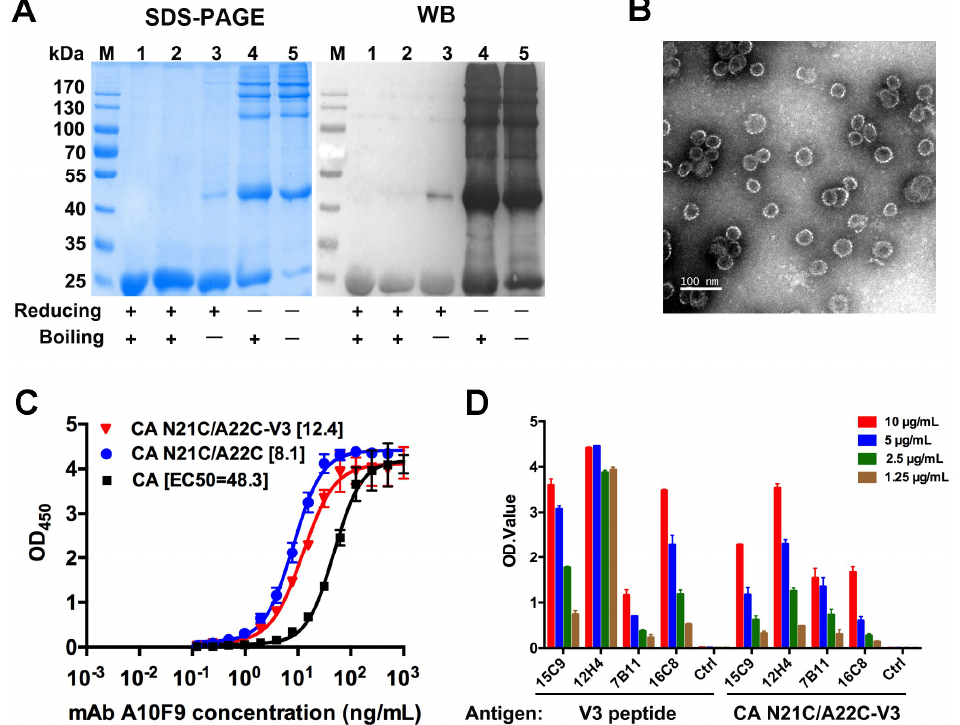
Figure 4. Characterization of CA N21C/A22C-V3. ( A ) SDS-PAGE and western blotting